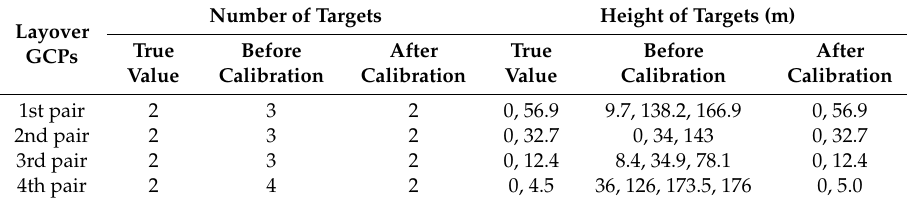
Table 2. Height resolution experiment on four pairs of layover GCPs.